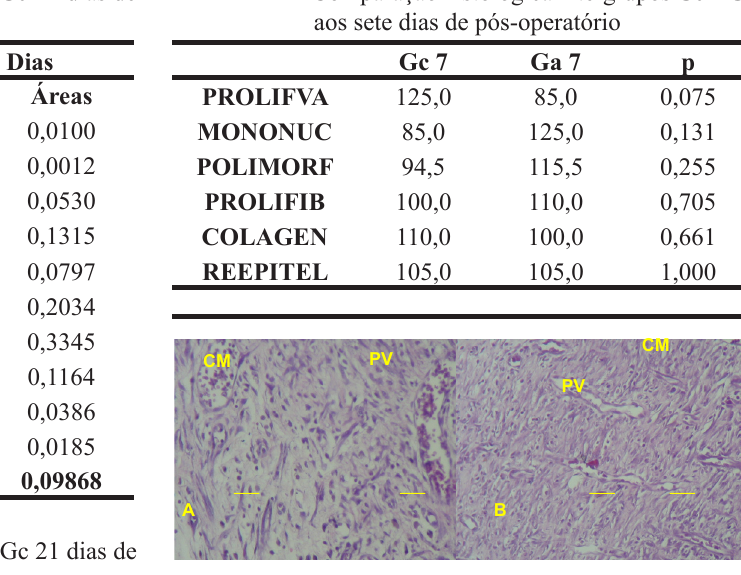
FIGURA 3 - Fotomicrografia de tecido de reparação da pele de ratos - sete dias de pós-operatório.